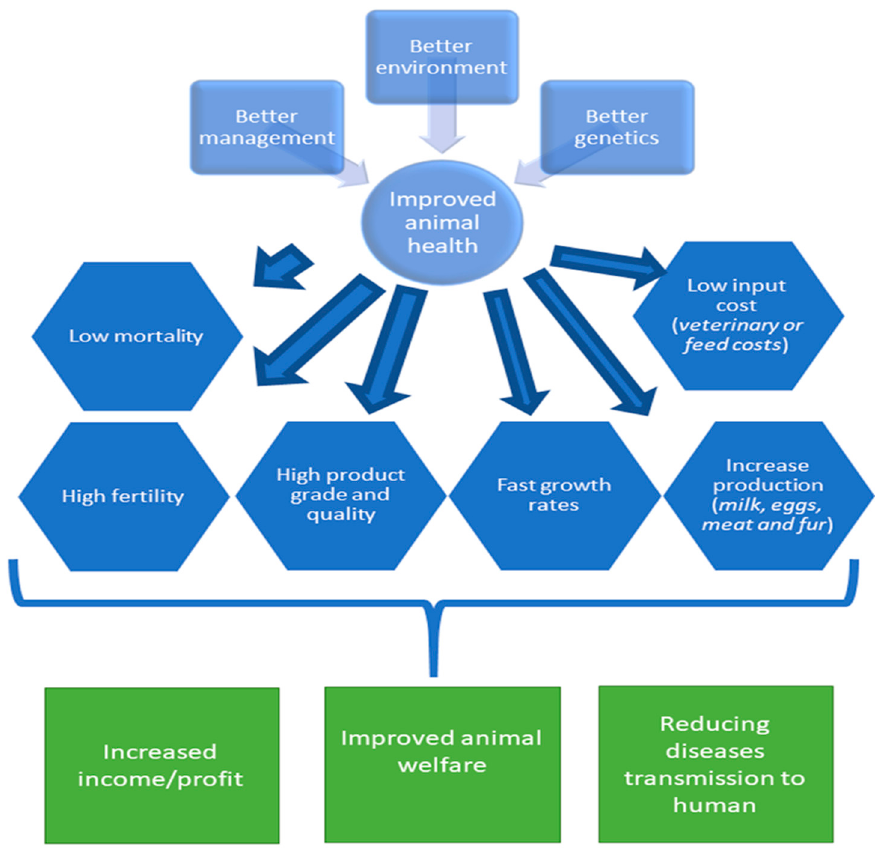
Figure 2. Overall benefits of selection for improved animal health.